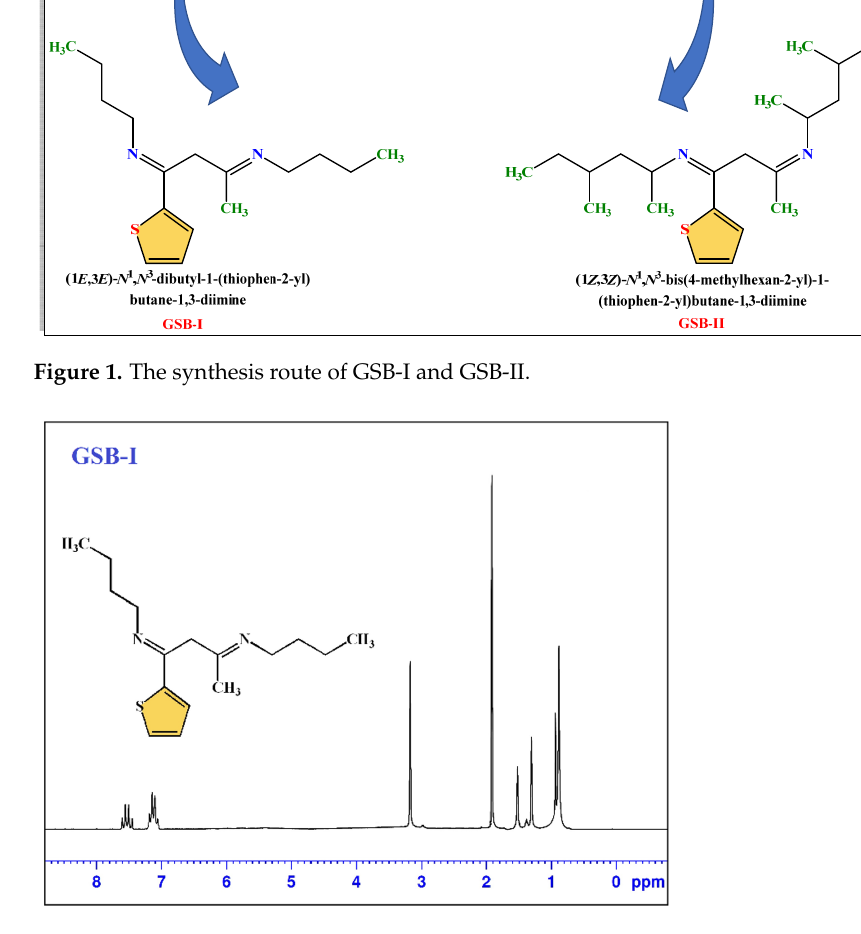
Figure 2. H 1 NMR spectrum of GSB compounds. 2.3. Specimens The API 5L X65 steel (CS) used was of a standard grade and its composition complied with NACE MR 0175. It consisted of a carbon content of 0.28 percent, 1.4 percent manga- nese, 0.03 percent phosphorus, and 0.03 percent sulfur, with the rest being elemental iron. For electrochemical impedance spectroscopy (EIS) and potentiodynamic polarization in- vestigations, a rod-shaped CS with a cross-exposed section of 0.5 cm 2 was utilized. The surface of each CS sample was polished with emery sheets ranging in grade from 400 to 2000. The samples were then thoroughly ultrasonically cleaned, degreased using a suita- ble solvent, and dried [29]. 2.4. PDP and EIS Experiments The studies on potentiodynamic polarization (PDP) and electrochemical impedance spectroscopy (EIS) were carried out using a three-electrode system. For the electrochemi- cal cell, reference (saturated-calomel-electrode, SCE), auxiliary (Pt-electrode), and work- ing electrodes (WE, CS-electrode) were utilized. Before the measurements, the WE were immersed in the electrochemical cell containing the acidic or inhibitory solution for 1800 s to achieve a steady state. The EIS was then performed with a frequency range of 0.01 to